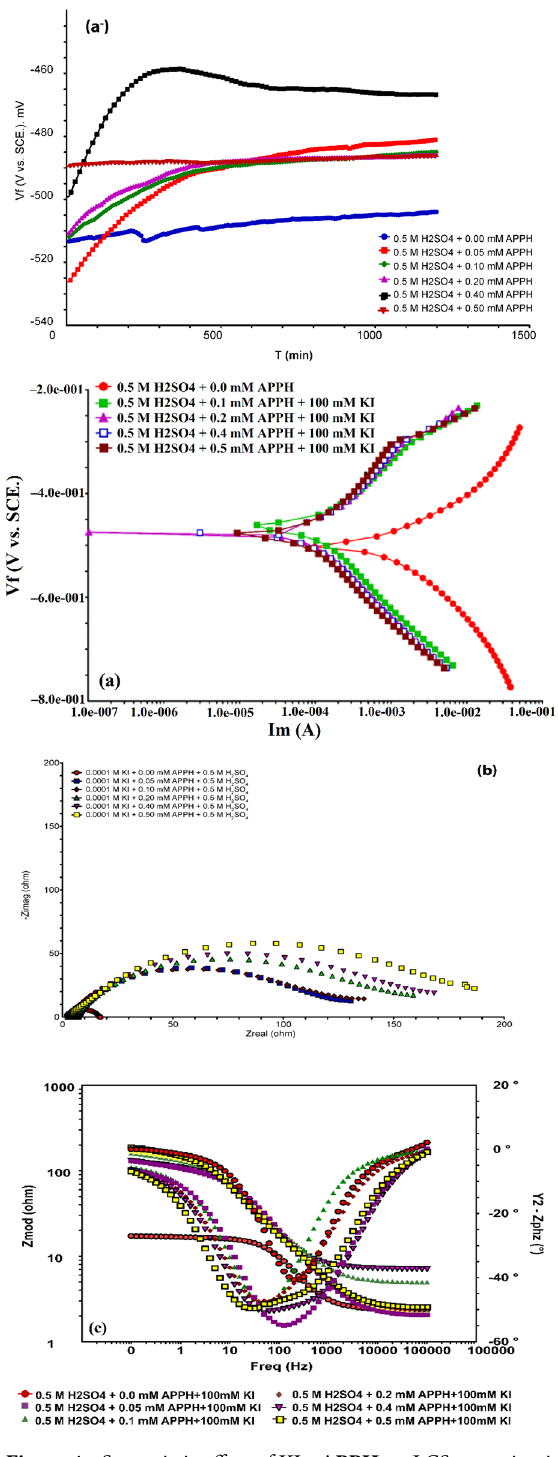
Figure 4. Synergistic effect of KI + APPH on LCS corrosion in 0.5 M H 2 SO 4 using ( a − ) OCP ( a ) Tafel; ( b ) Nyquist grave; and ( c ) Bode plots